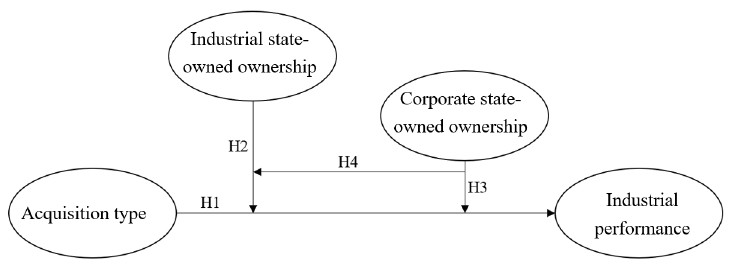
Figure 1. Relationship between acquisition type and industrial